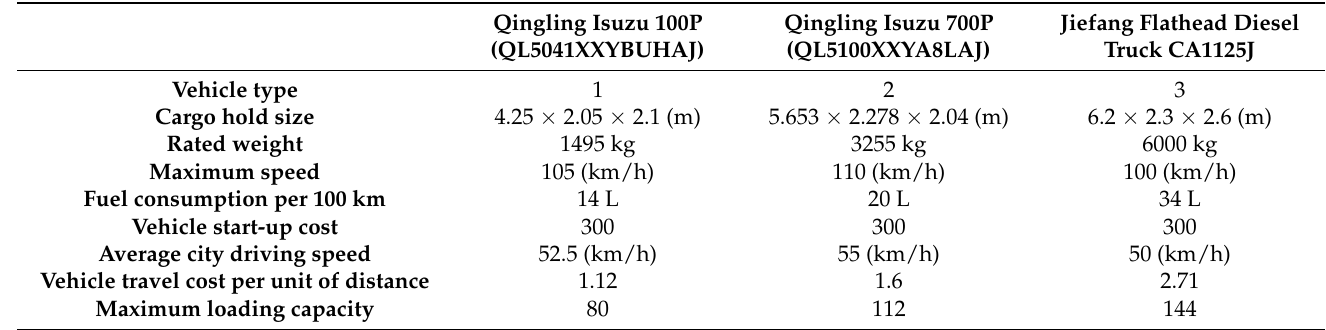
Table 9. Vehicle parameters.